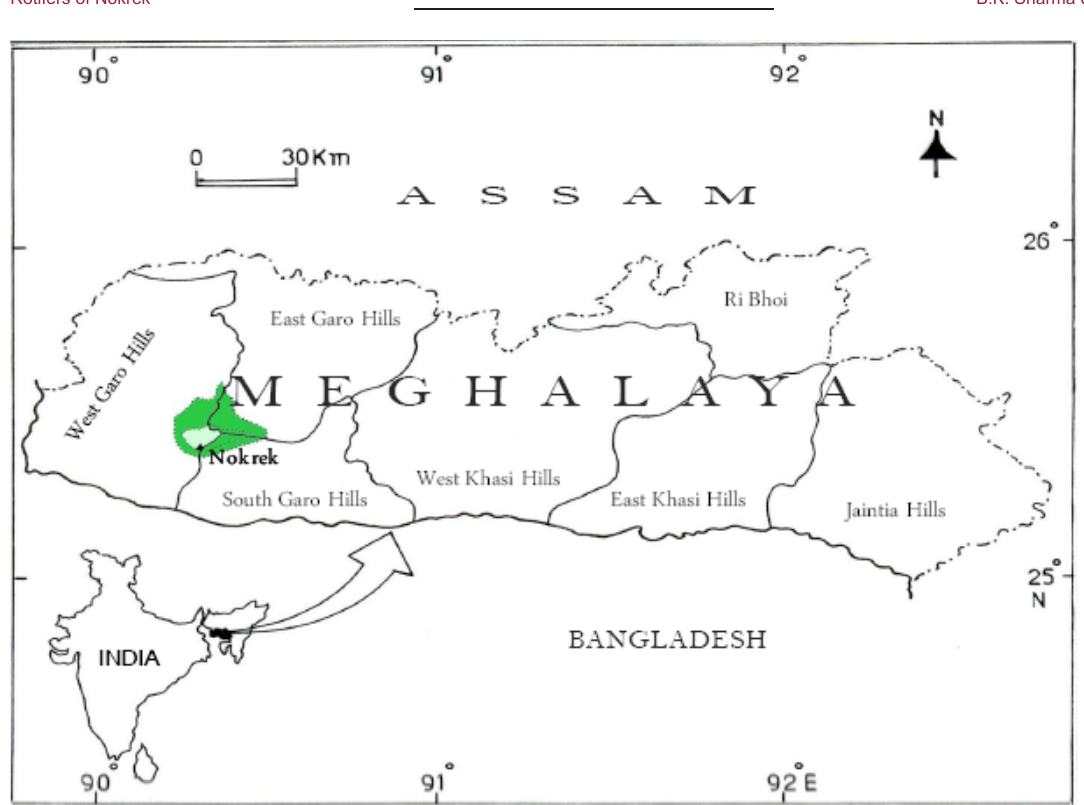
Figure 1. District map of Meghalaya showing location of Nokrek (inset map of India showing locationof Meghalaya